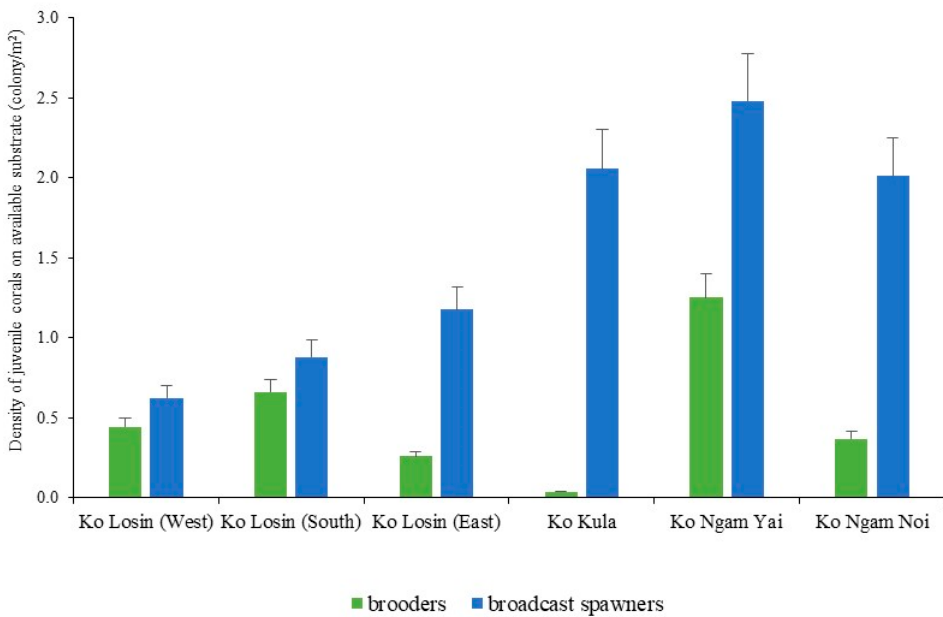
Figure 12. Densities of juvenile corals on available substrate for broadcast spawners and brooders at the study sites. Error bars indicate standard deviation.